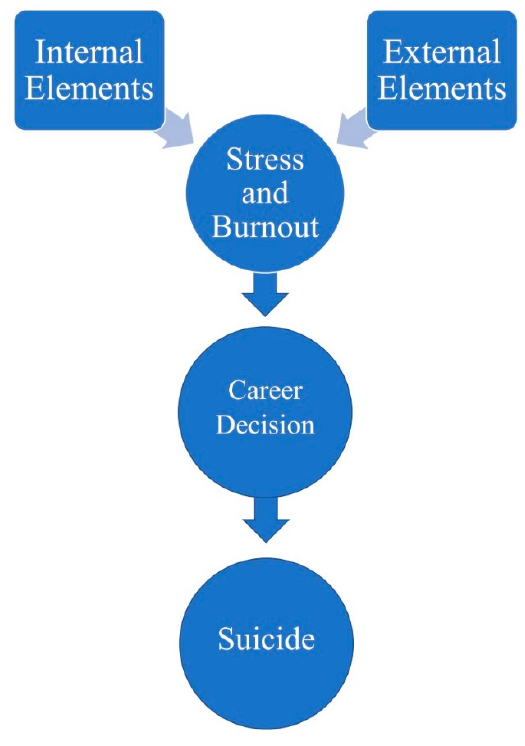
Figure 1. The approach of stress, burnout, career decision, and suicide.